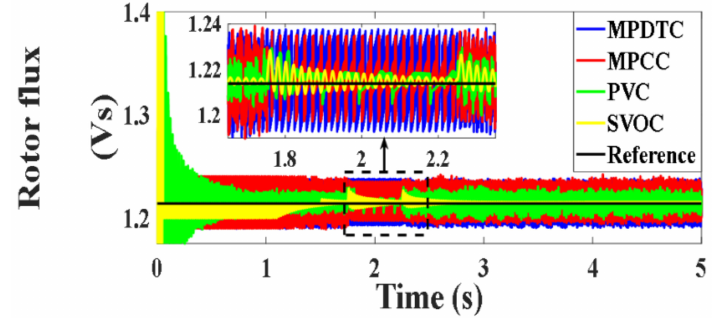
Figure 189. Comparison between rotor fluxes of four techniques (Vs).